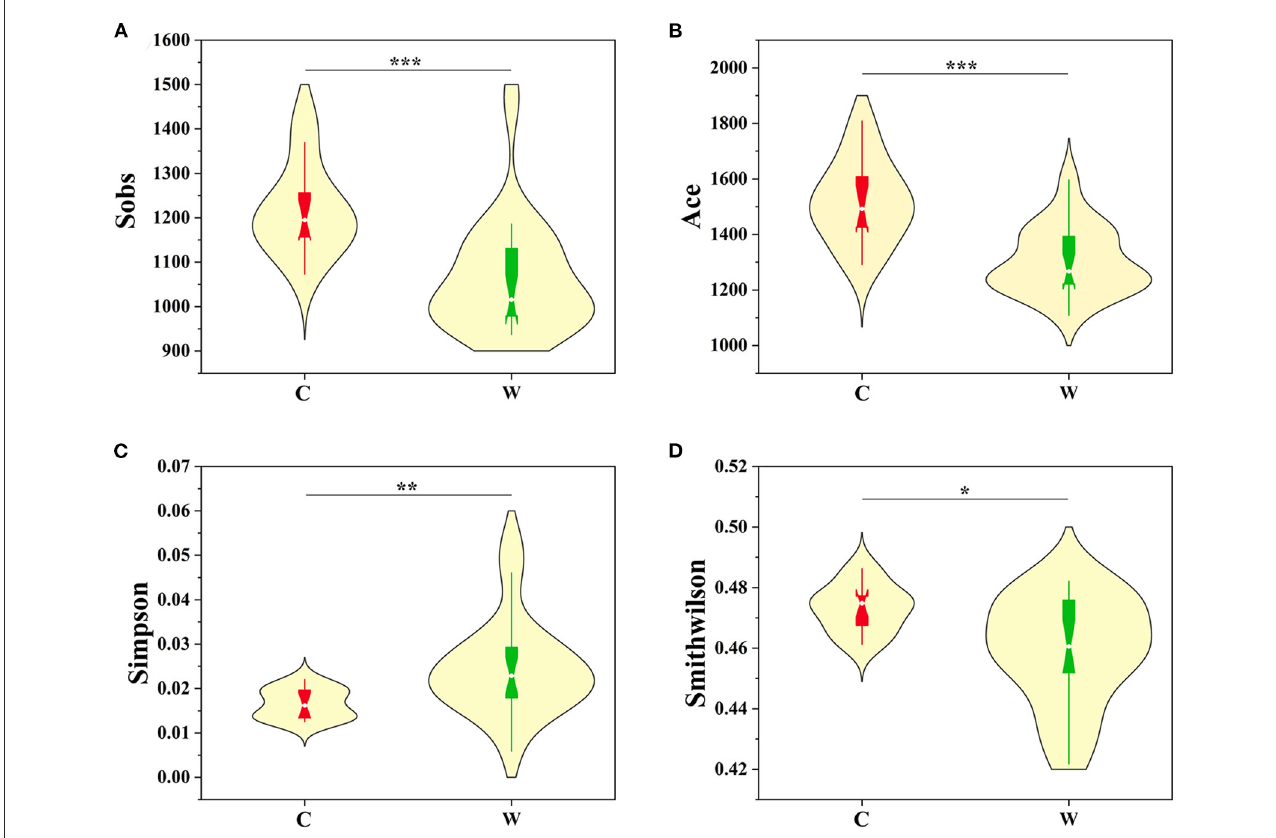
FIGURE1 Comparison of alpha diversity indices [ (A) Sobs, (B) Ace, (C) Simpson, and (D) Smithwilson] of gut microbiota of the captive (C) and wild (W) Alpine musk deer (significance * p < 0.05, ** p < 0.01, and *** p <